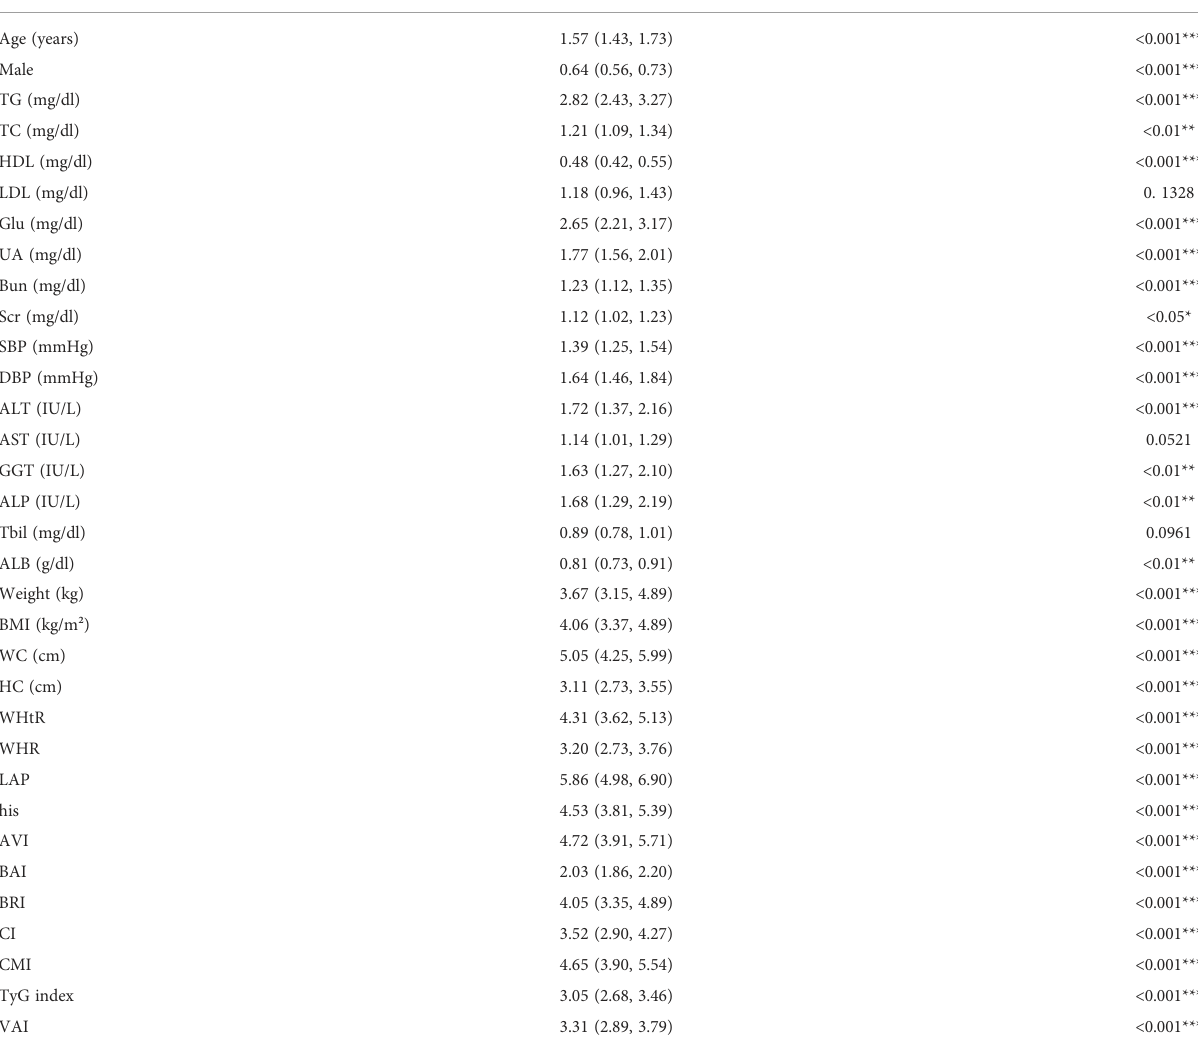
TABLE 2 Univariate logistic regression models evaluating the association of demographic, biochemical and clinical characteristics, and anthropometric indexes with MAFLD (Per SD increment for continuous variables). HR, 95% CI(Per SD increment for continuous variables)